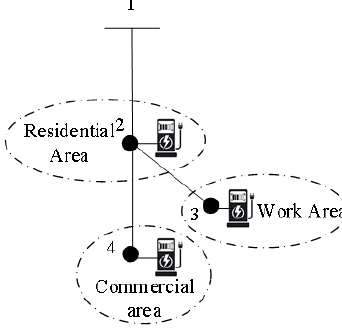
Figure 1. Topological diagram of a four-node network divided into different functional areas.